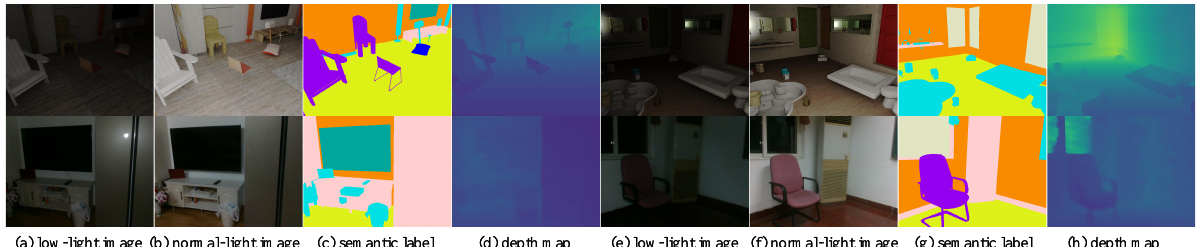
Figure 3. Sample images from the proposed LLRGBD data sets. The images in the first row are synthetic, and the second row shows some real images.